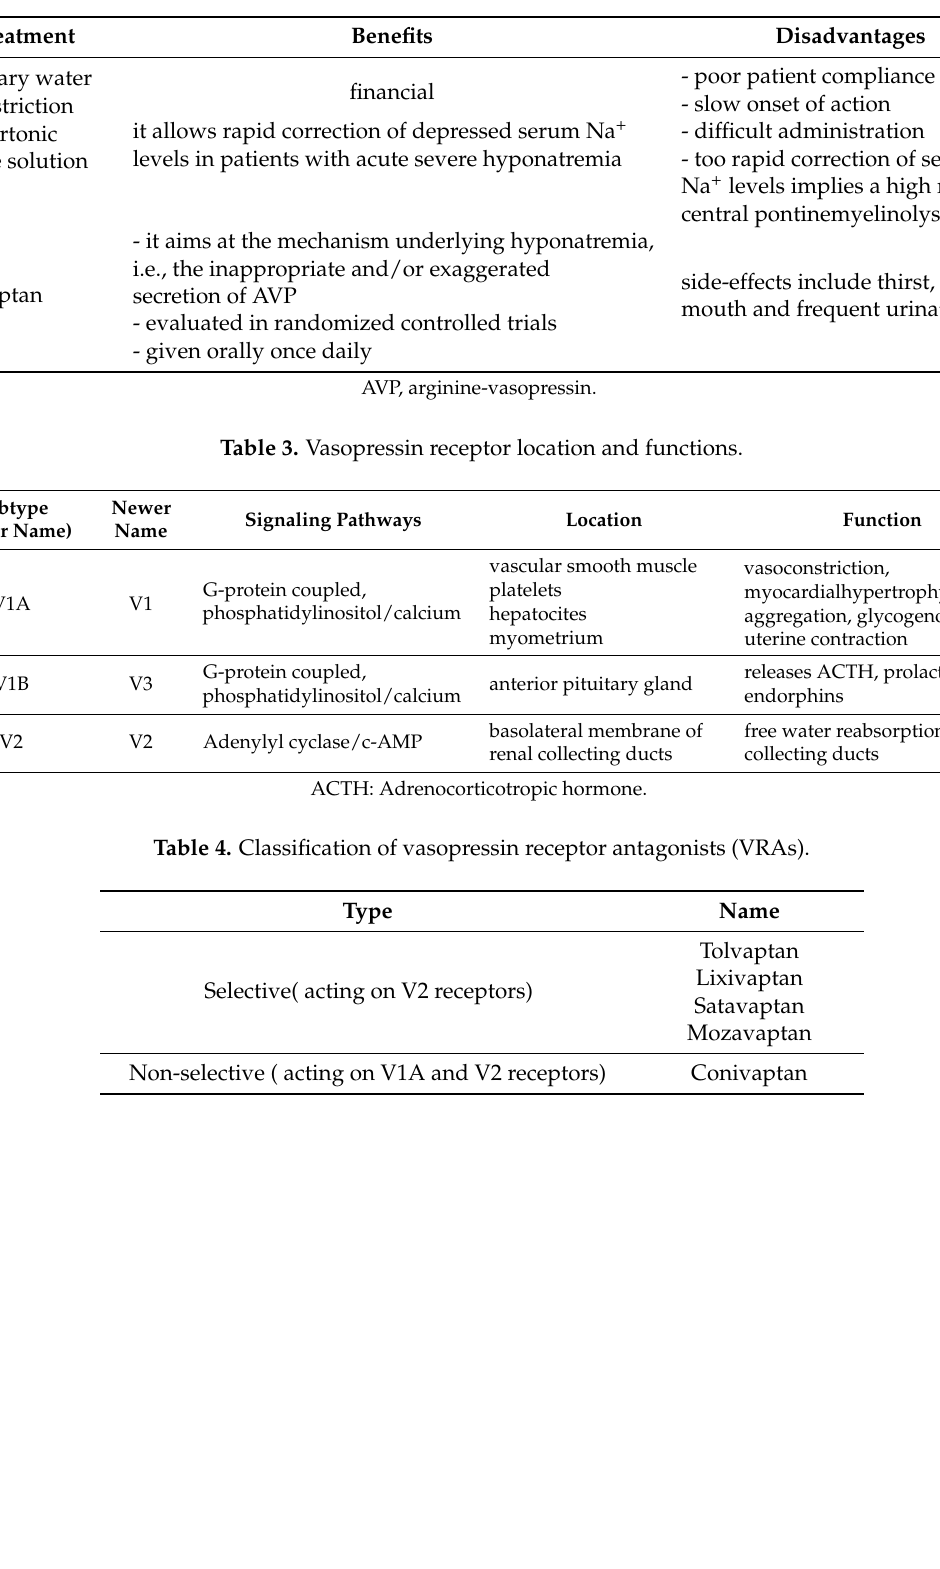
Table 2. Main features of therapies used for hyponatremia.